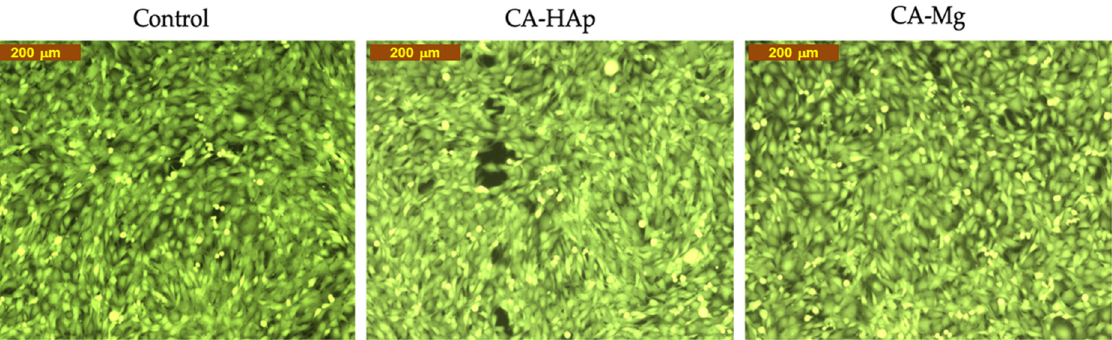
Figure 15. Fluorescent microscopy images for CA-HAp and CA-Mg in contact with cell cultures for 72 h (dye Calcein AM). Image obtained with Inverted Phase-Contrast Microscope, Leica, Germany (10× objective).